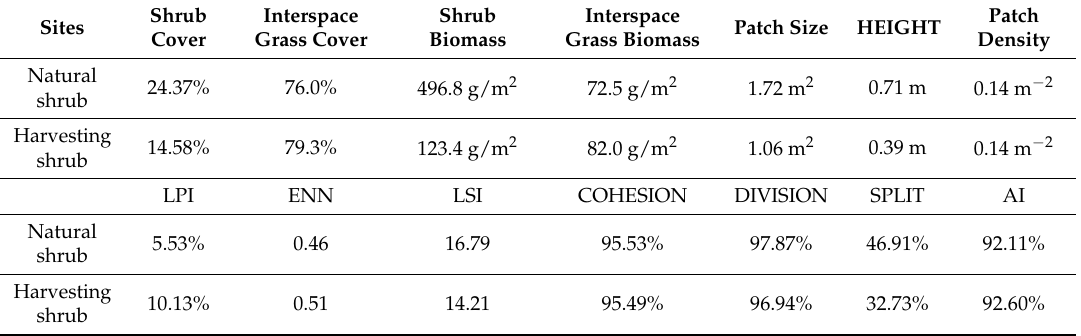
Table 1. The comparison of landscape indices between natural and harvesting shrub encroached grassland. Shrub Interspace Shrub Sites Cover Grass Cover